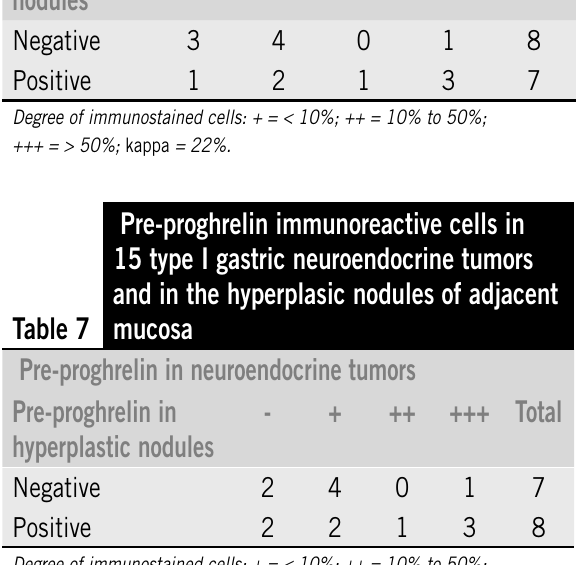
was predominantly diffuse while the presence of ghrelin and pre-proghrelin positive cells varied in each case ( Tables 4 and 5 ) ( Figure 2 ). The expression of ghrelin immunoreactive cells in the hyperplasic nodules was observed in seven (47%) and pre- proghrelin in eight (53%) cases ( Tables 6 and 7 ).